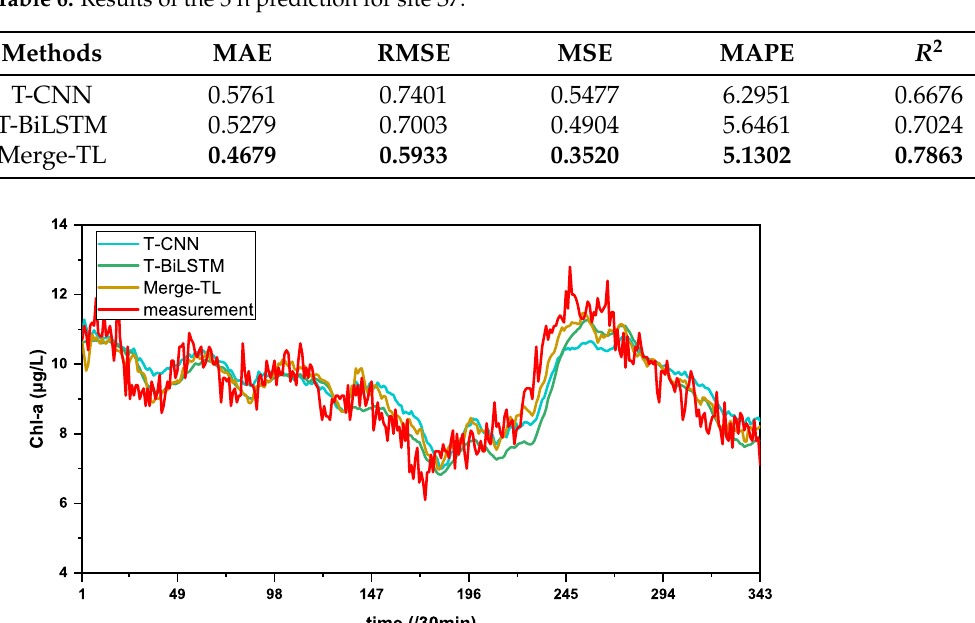
Table 6. Results of the 3 h prediction for site S7.